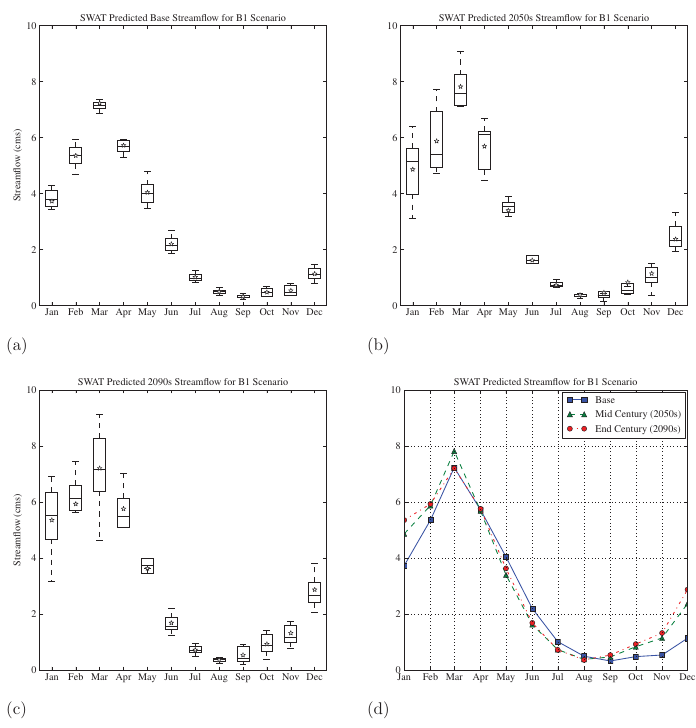
Figure 6. SWAT predicted monthly average streamflow. ( a ) Base period (1970–2000); ( b ) Mid-Century Figure 5.5: SWAT predicted monthly average streamflow. (a) Base period (1970- (2048–2065); ( c ) End-Century (2085–2099); from eight GCMs predicted B1 emission scenarios at USGS 2000); (b) Mid Century (2048-2065); (c) End Century (2085-2099); from 8 GCMs predicted B1 emission scenarios at USGS station 02085070; (d) the average streamflow station 02085070; and, ( d ) the average streamflow over the eight GCMs for the three study over the 8 GCMs for the three study periods. also suggest a wider range of monthly average inorganic nitrogen values for the A2 scenario than the B1 scenario (Figure 5.6 and 5.7 and Table 5.3). Like streamflow, the